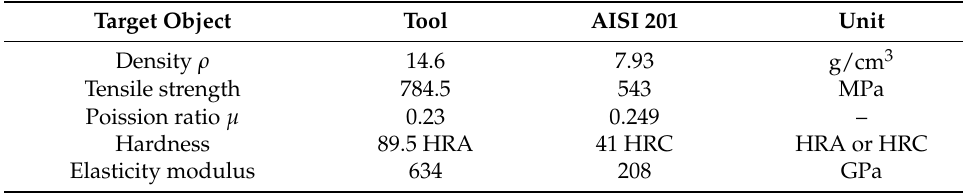
Table 2. Physical properties of Tool and Workpiece.